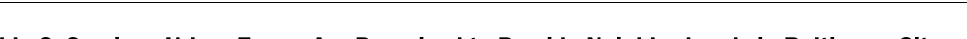
Table 2. Services Urban Farms Are Perceived to Provide Neighborhoods in Baltimore City Service Exemplary Quotation